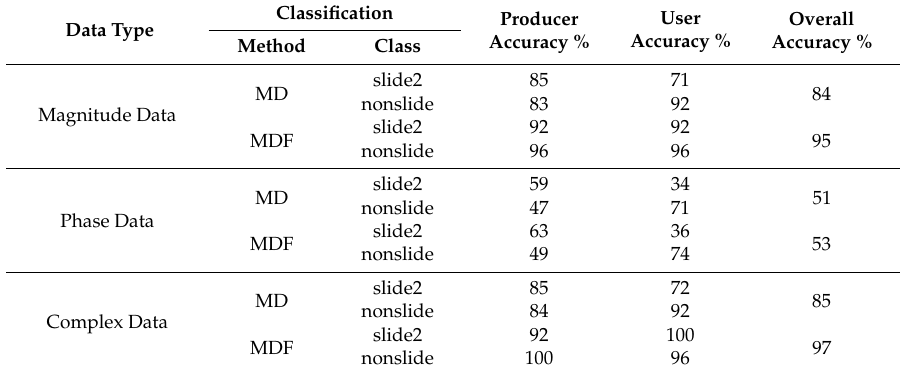
Figure 9. Phase data classification for the segment Sample 2: ( a ) without majority filter; ( b ) with majority filter; ( c ) optical image overlaid with slide and nonslide class shapes. Table 4. Accuracy analysis of the Mahalanobis distance (MD) classification, and with majority filter (MDF) for slide and nonslide areas, of the segment Sample 2, using magnitude, phase, and complex data.